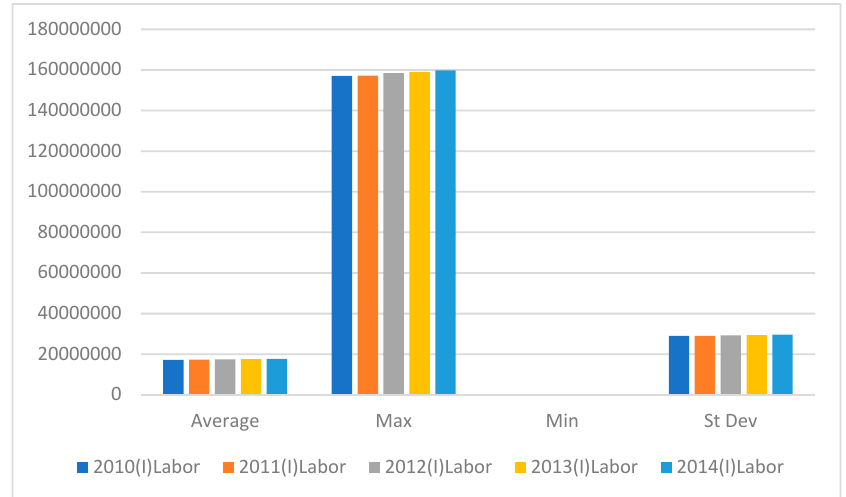
Figure 1. Labor Input variables from 2010–2014.